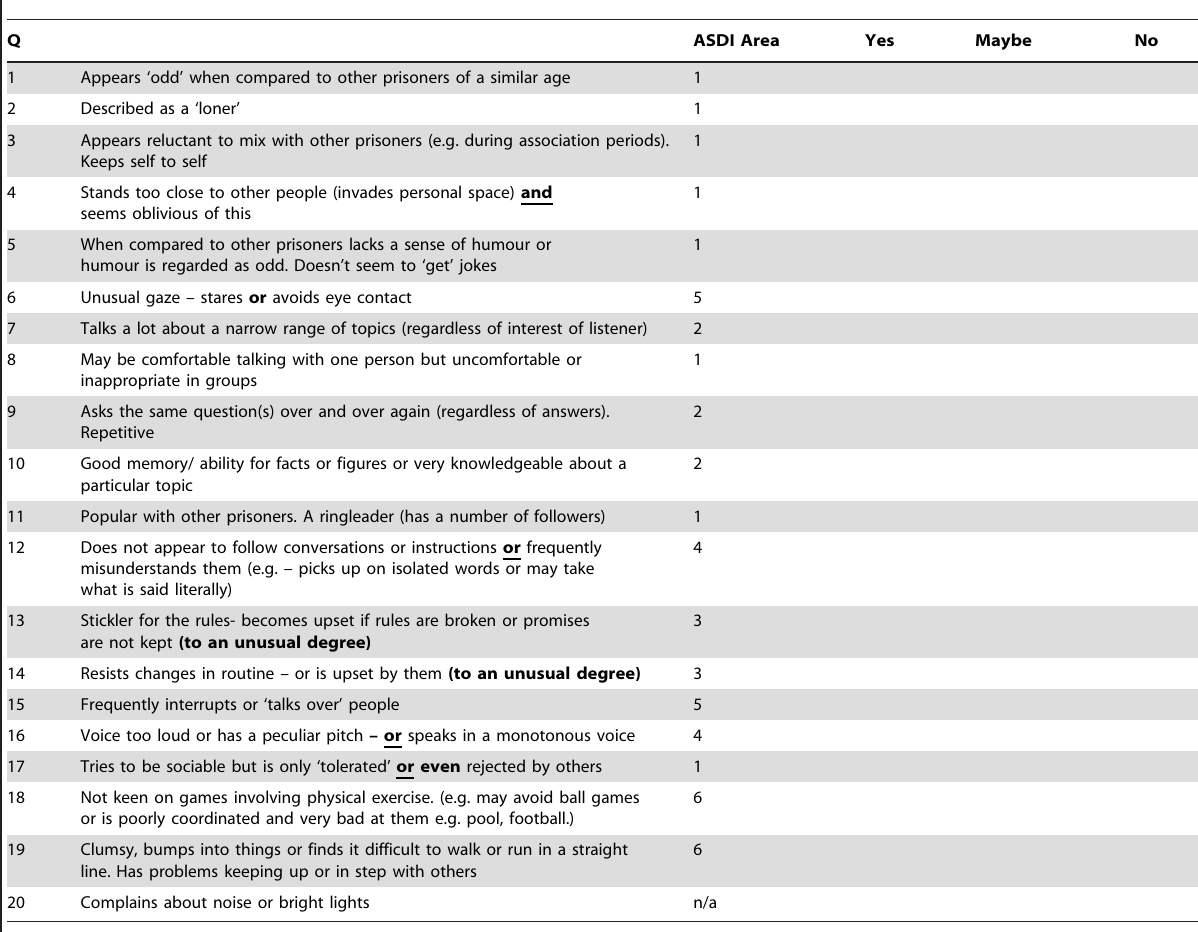
Table 1. ASD screening